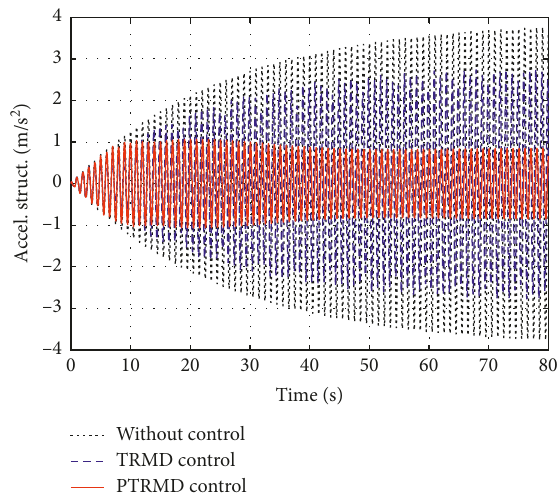
Figure 13: Acceleration response of the structure under free vibration.